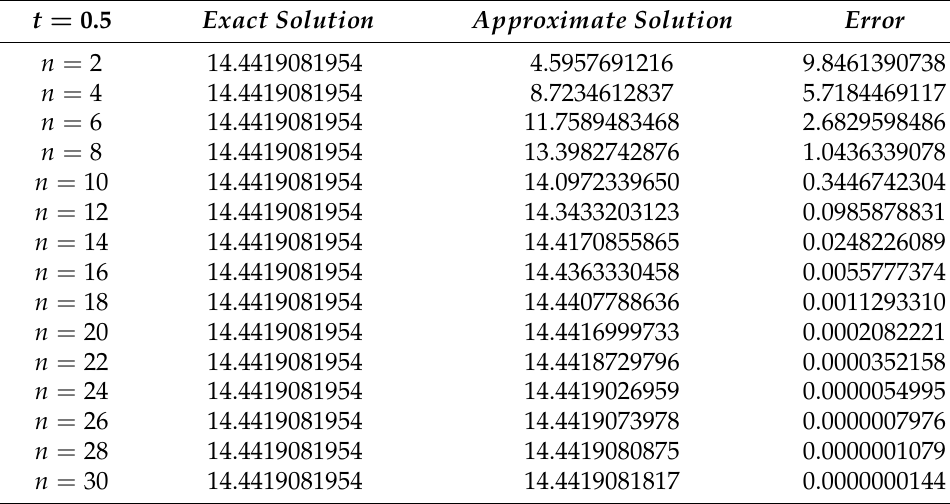
Table 2. Error estimates at x = y = 0, t = 0.5 for α = 0.5.